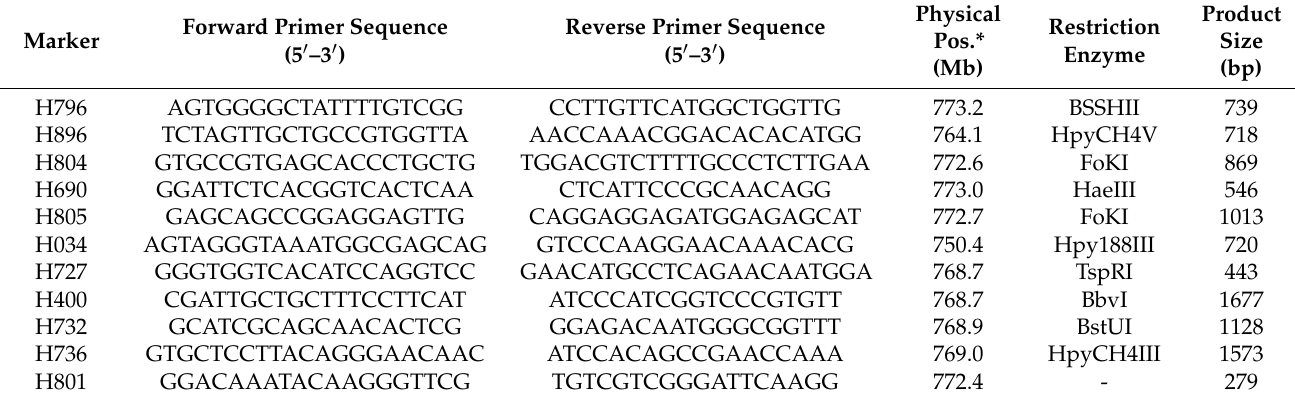
Table 2. Markers developed for mapping YrJ22 .